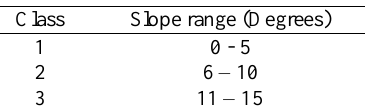
Table 1. The slope classification over study area